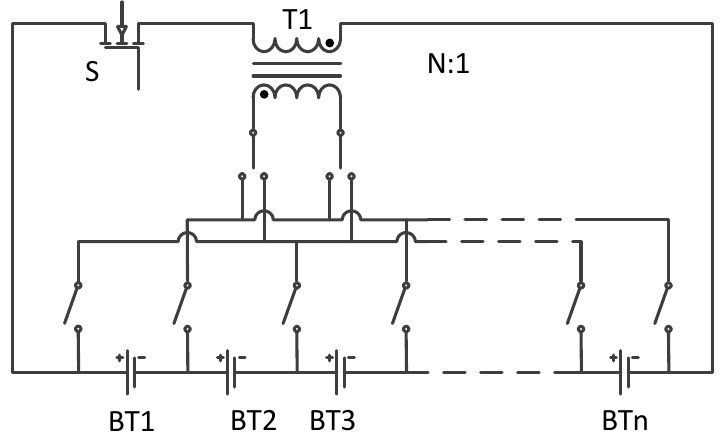
Figure 7. Principle of switching transformer balance.